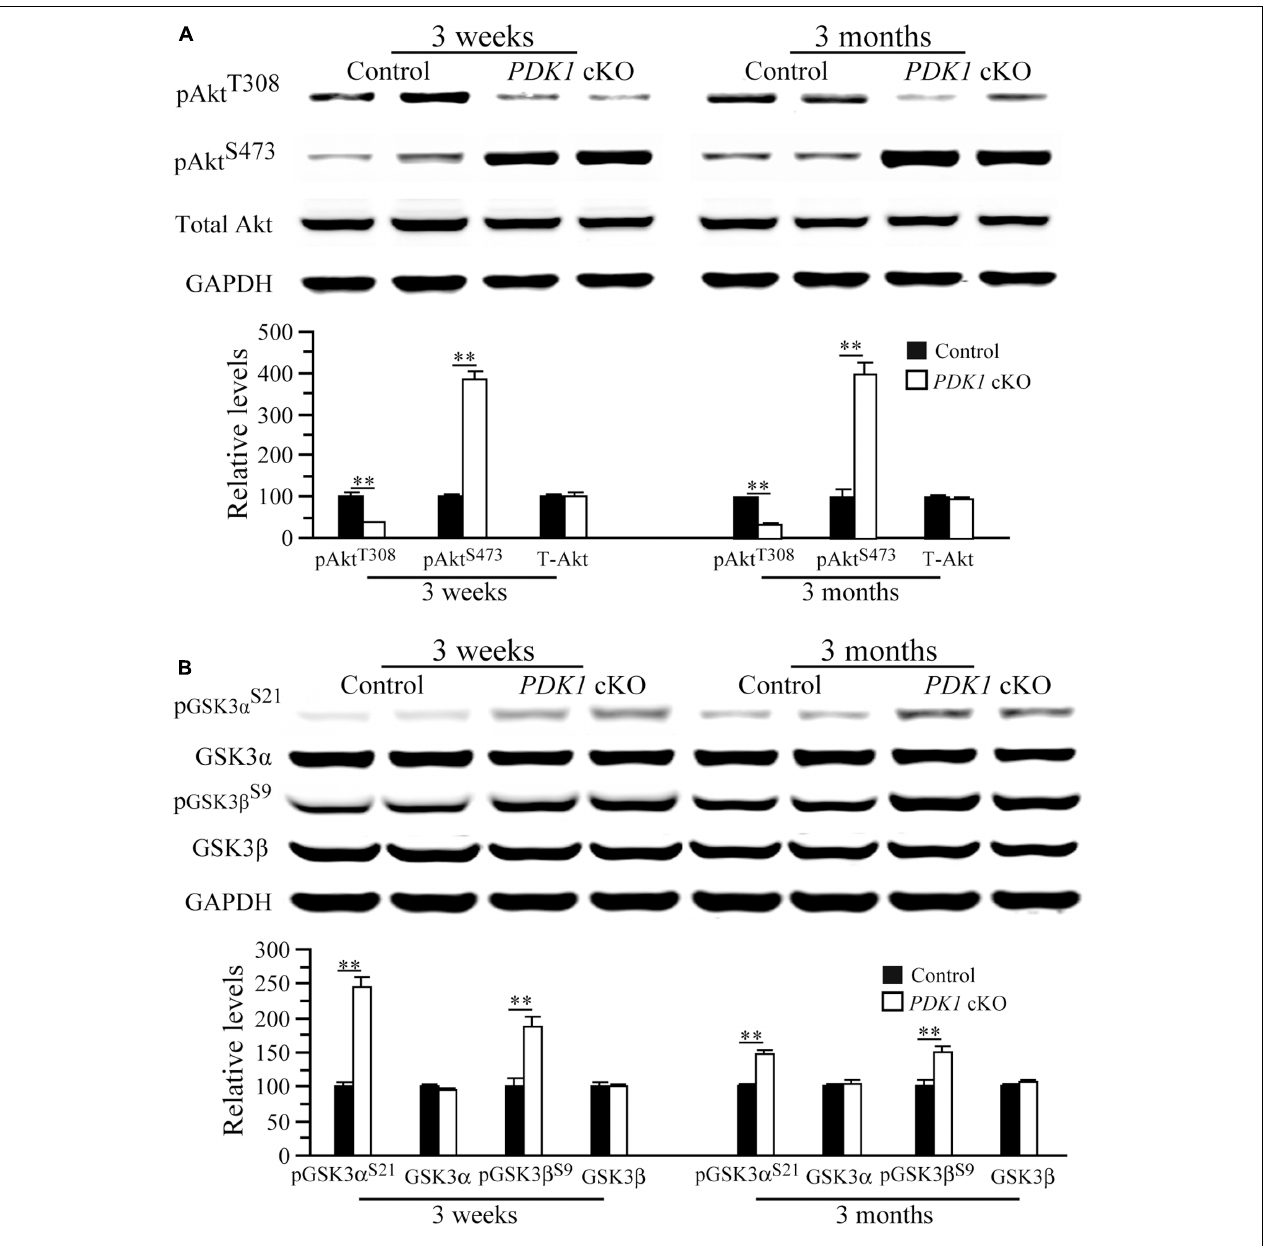
FIGURE 6 | Levels of pAkt and pGSK3 in PDK1 cKO mice. (A) Western analyses on pAkt and total Akt (T-Akt). There were significant differences on relative levels of pAkt T308 and pAkt S473 between control and PDK1 cKO mice at 3 weeks and 3 months ( ∗∗ p < 0.01; n = 3–4/group/age). There was no significant difference on T-Akt levels between control and PDK1 cKO mice at either age ( p s > 0.2). GAPDH served as the loading control. (B) Western analyses on pGSK3 α , pGSK3 β , total GSK3 α , and total GSK3 β . There were significant differences on relative levels of pGSK3 α S21 and pGSK3 β S9 between control and PDK1 cKO mice at 3 weeks and 3 months ( ∗∗ p < 0.01). There were no significant differences on levels of total GSK3 α and GSK3 β between control and PDK1 cKO mice ( p s > 0.5). GAPDH served as the loading control.